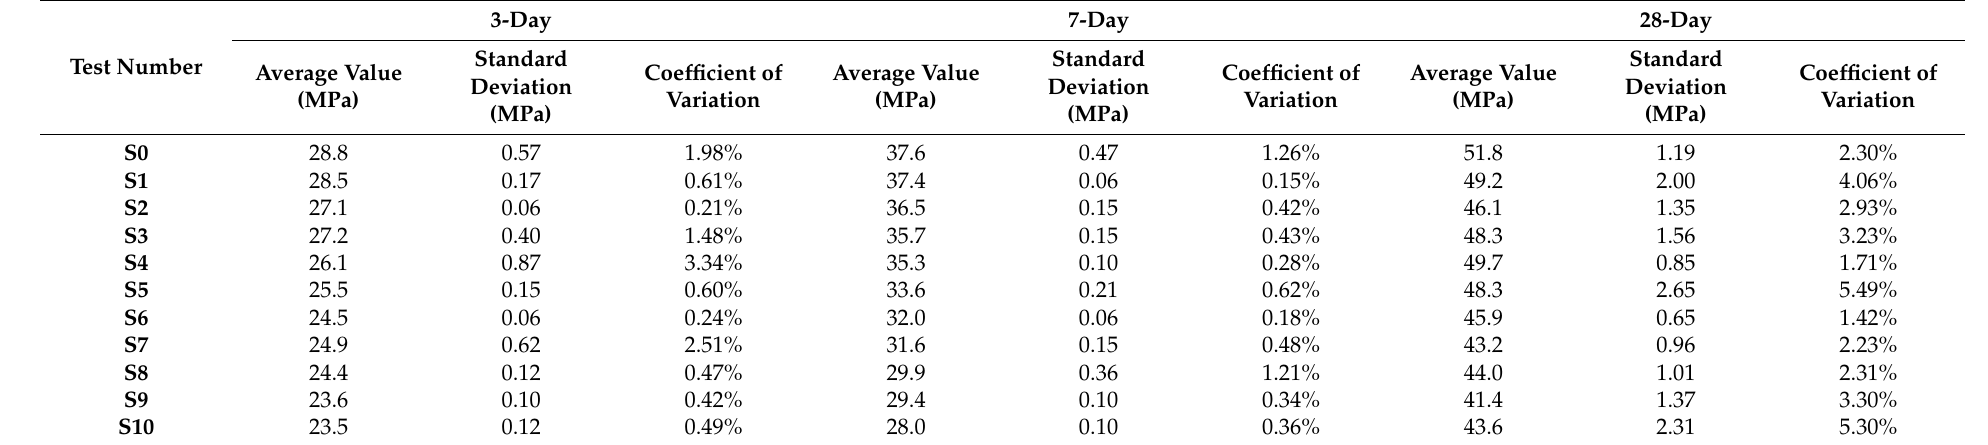
Table 7. Test results of mortar compressive strength of standard sand.